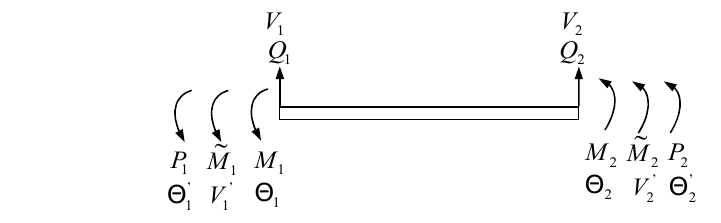
Fig. 3. Boundary conditions for displacements and forces of beam